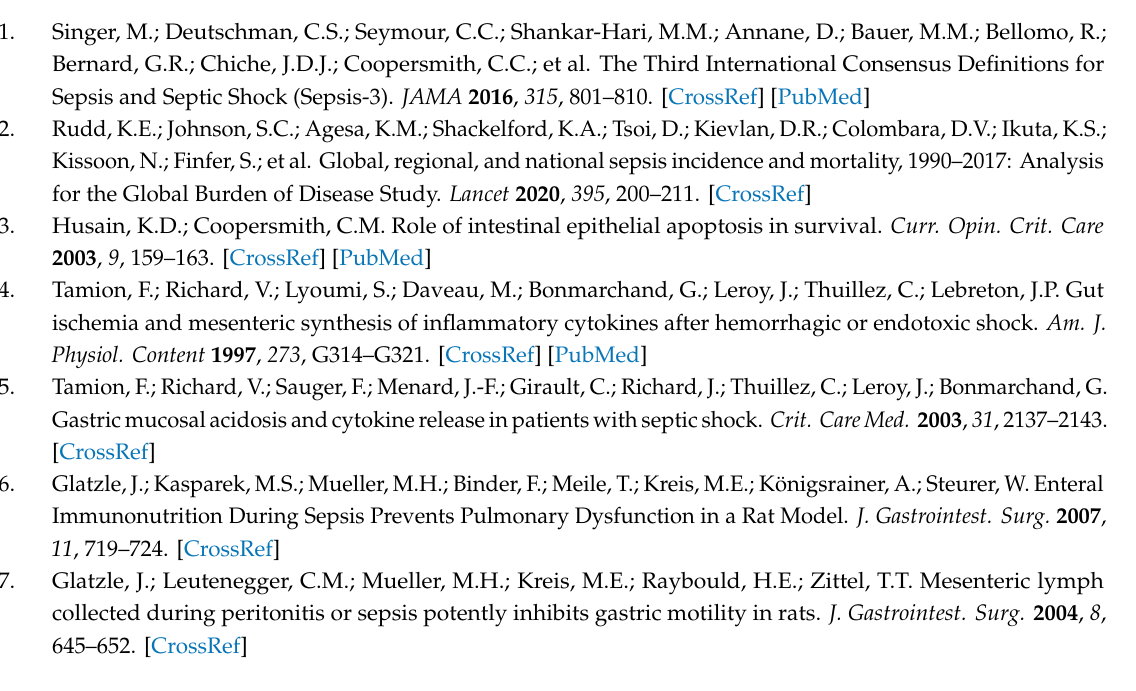
Table S1. Primer sequences used in RT-qPCR. Table S2. All miRNAs detected, RPKM values, and fold changes. Table S3. RPKM values and fold change of miRNAs targeting TNF- α and